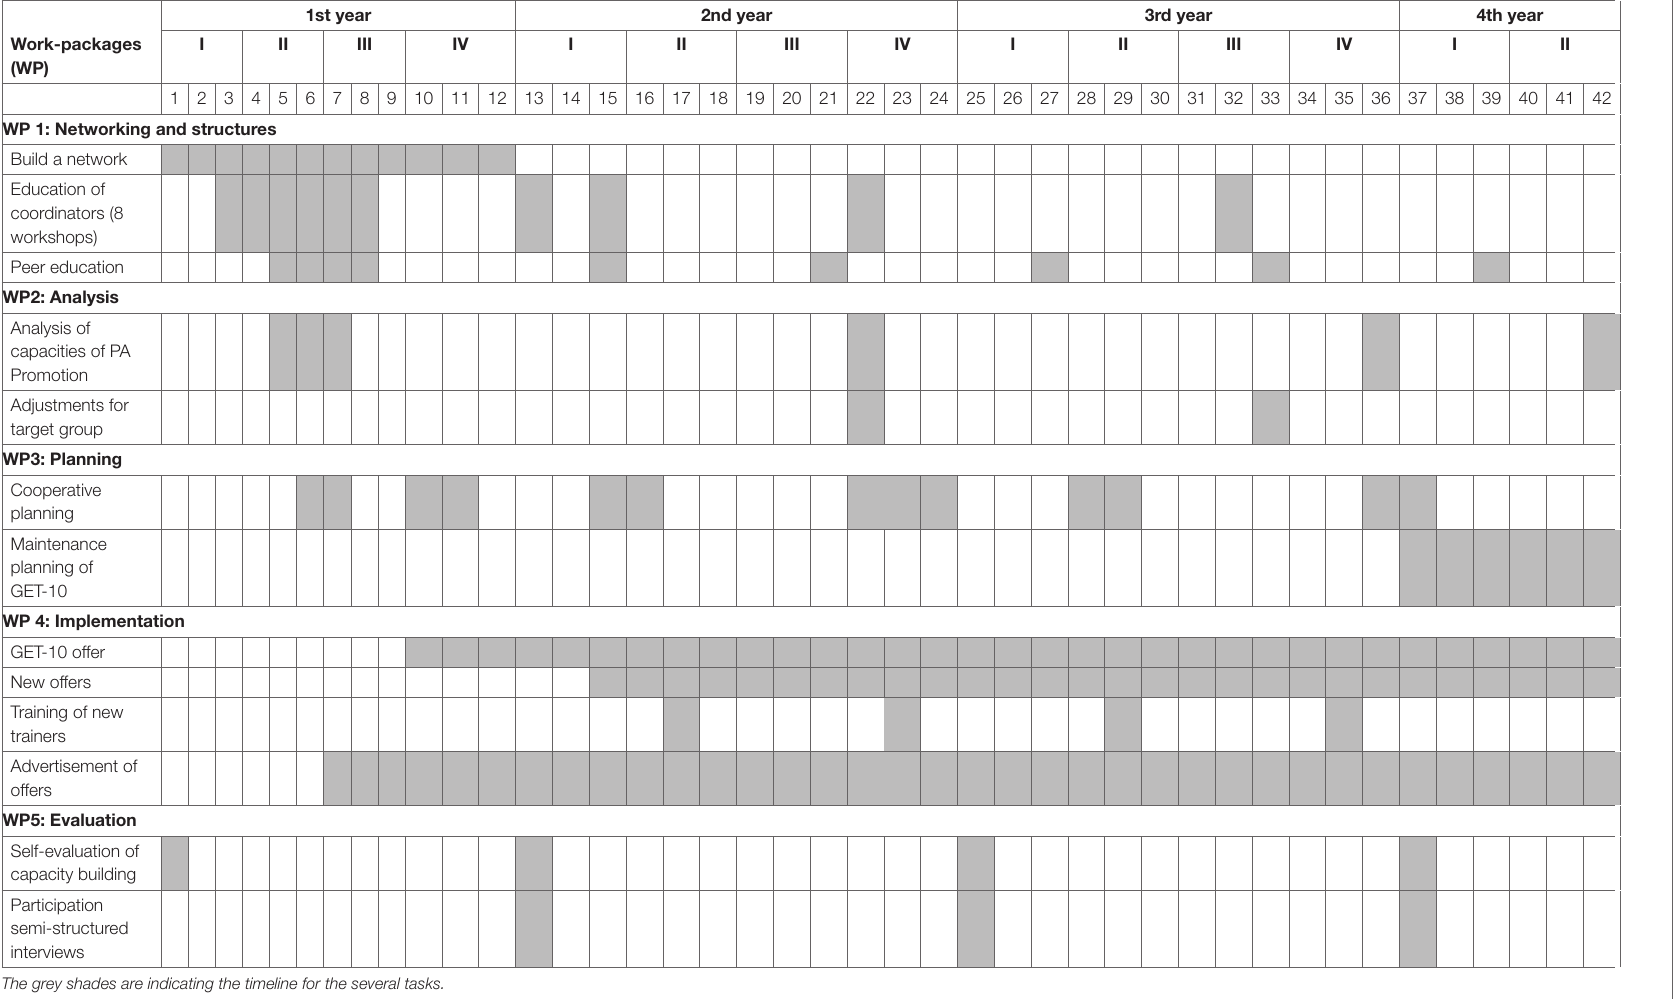
The grey shades are indicating the timeline for the several